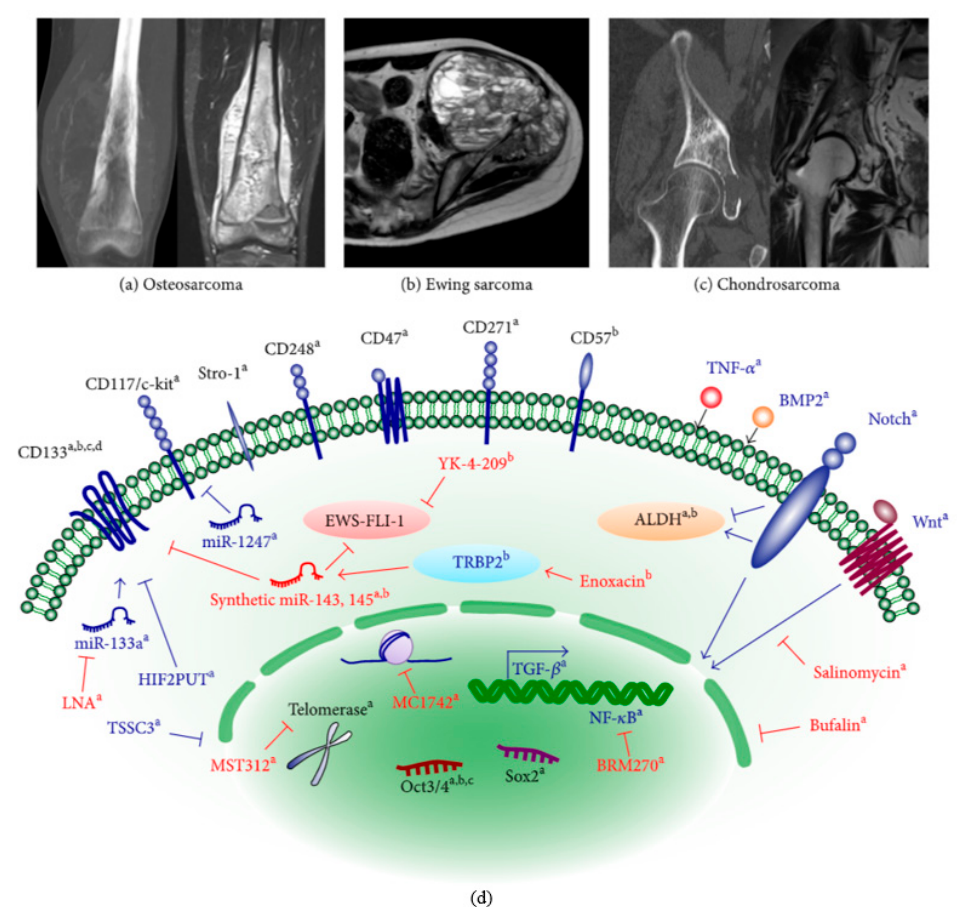
Figure 2. Bone sarcoma stem cells overview. ( a ) osteosarcoma; ( b ) Ewing sarcoma; ( c ) chondrosarcoma. ( d ) A broad spectrum of CSC markers (black) and the molecular mechanisms underlying CSC phenotypes (blue) have been documented for each sarcoma. Several anti-CSC compounds (red) have been preclinically tried to inhibit CSC phenotypes. Reprinted from an open-access source [20].